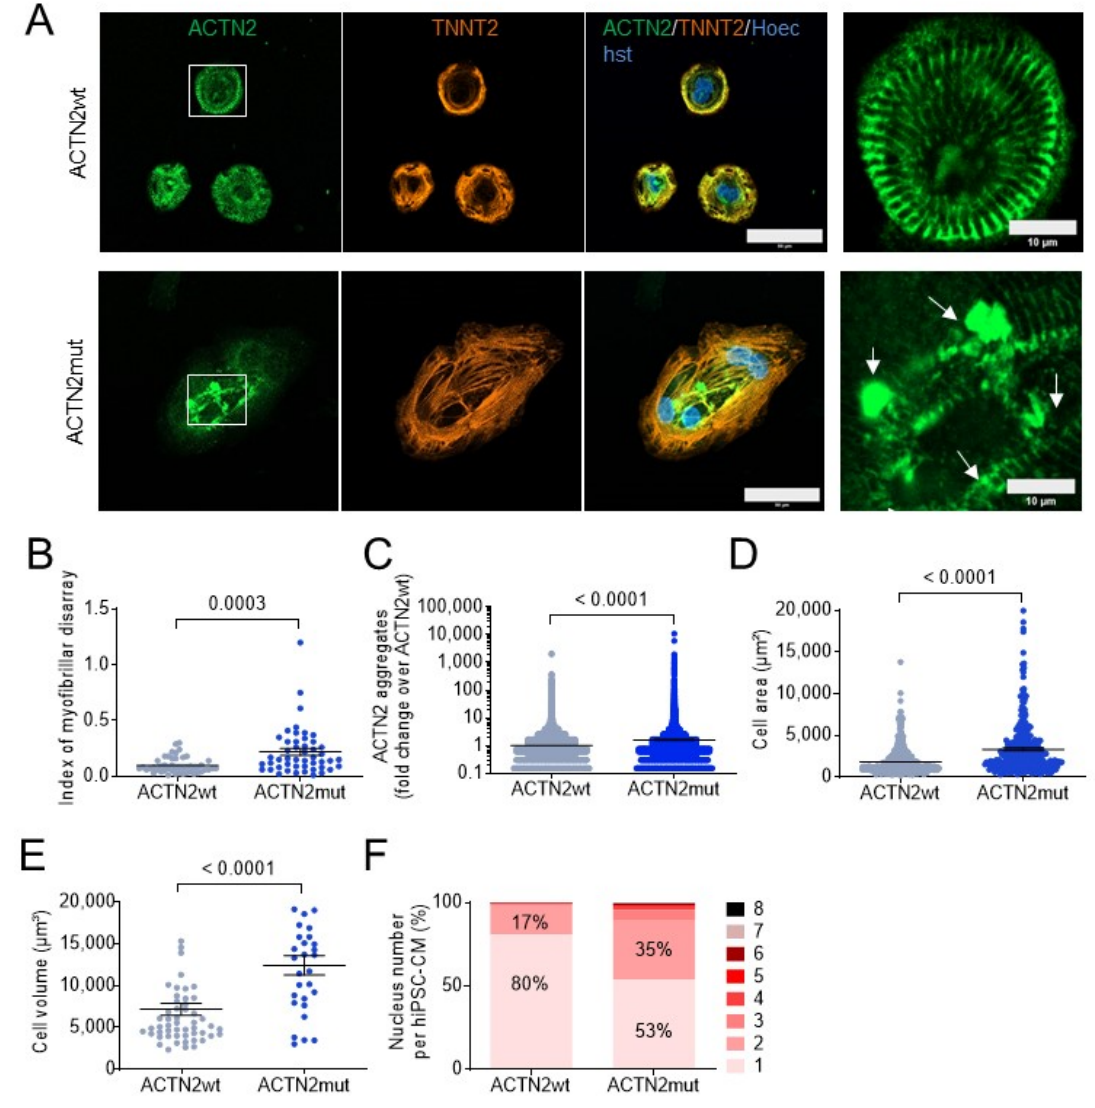
Figure 1. Disease modeling in 30-day-old, 2D-cultured hiPSC-CMs. ( A ) Representative immunoflu- orescence images of hiPSC-CMs (scale bar = 50 µ m), including a higher magnification on the right (scale bar = 10 µ m). After 30 days, hiPSC-CMs were fixed and stained with antibodies against ACTN2 and TNNT2, and with Hoechst for nuclei. ( B ) Blinded analysis of myofibrillar disarray using high-resolution pictures (ACTN2wt and ACTN2mut: N/d = 16/3). ( C ) Quantification of ACTN2 aggregates analyzed with Fiji software (ACTN2wt: N/d = 14/3, ACTN2mut: N/d = 15/3). ( D ) Quan- tification of cell area was analyzed with Fiji software (ACTN2wt: N/n/d = 548/3/3, ACTN2mut: N/n/d 319/3/3). ( E ) Quantification of cell volume analyzed with Imaris software (ACTN2wt: N/n/d = 54/3/3, ACTN2mut: N/n/d = 29/3/3). ( F ) Quantification of nucleus number per hiPSC-CM analyzed with Fiji software and expressed as percentage (ACTN2wt: N/n/d = 548/3/3, ACTN2mut: N/n/d = 319/3/3; Chi-square = 280.1, p < 0.0001). Data are expressed as mean ± SEM (panels B – E ) or percentages (panel F ), with p -values obtained with the unpaired Student’s t -test (panels B – E ) or two-tailed Chi-square test (panel F ). Abbreviations: TNNT2, cardiac troponin T; N/n/d, number of cells/wells/differentiations. Arrows point to